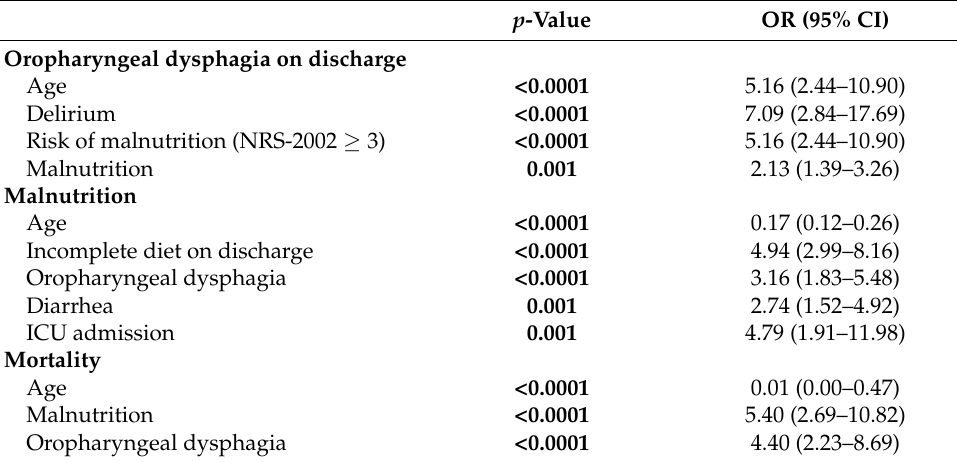
Table 7. Multivariate logistic regression analysis of risk factors associated with oropharyngeal dysphagia on discharge, malnutrition and